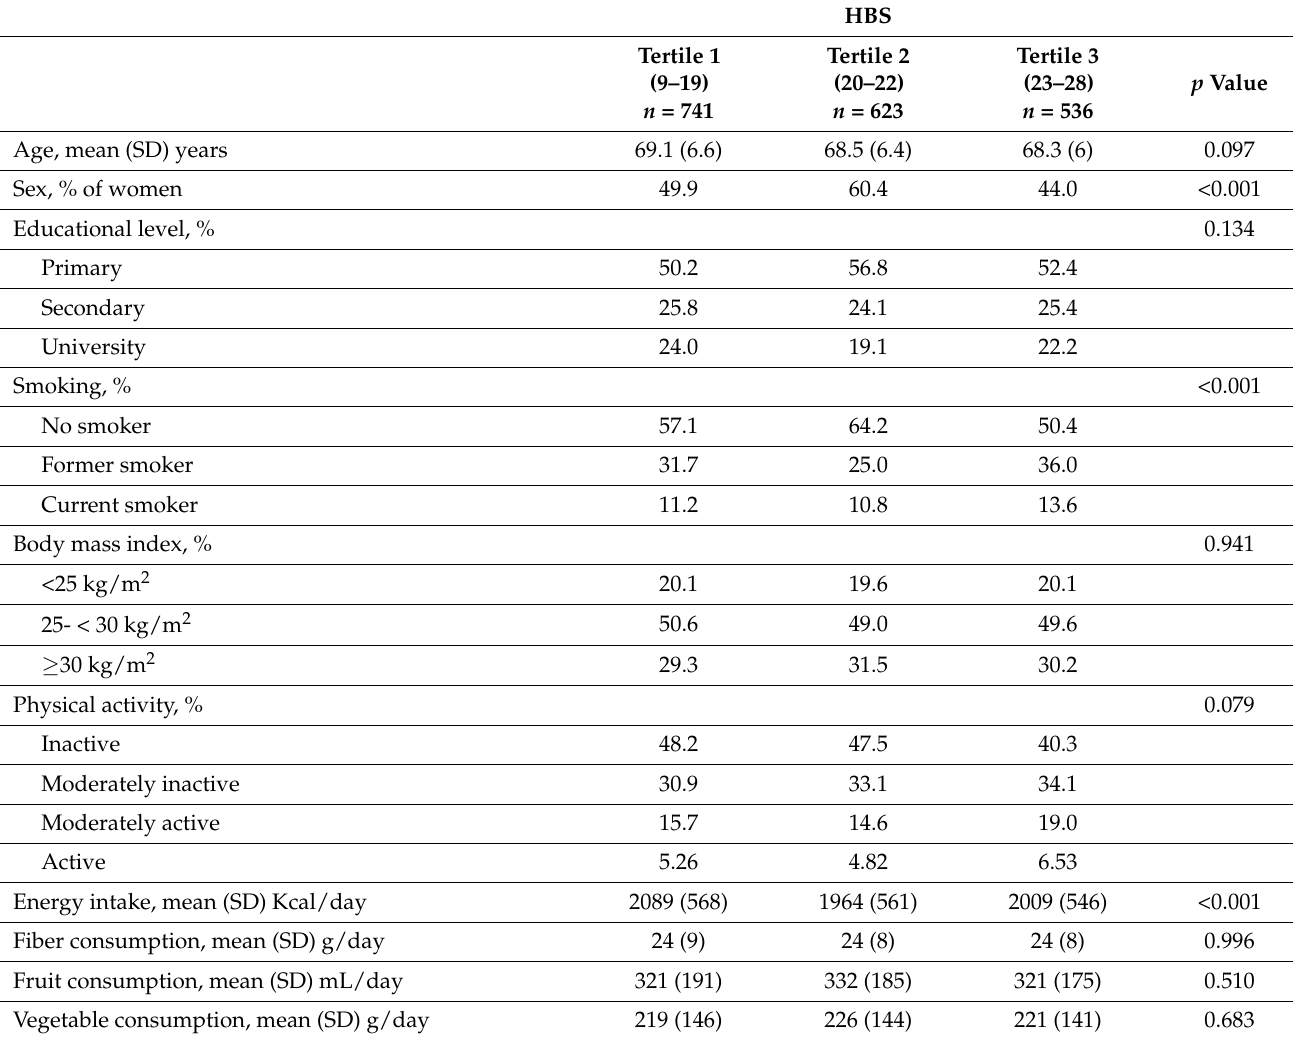
Table 2. Baseline characteristics of the Seniors-ENRICA-1 cohort participants (2008–2010) by tertiles of Healthy Beverage Score (HBS) adherence ( n =